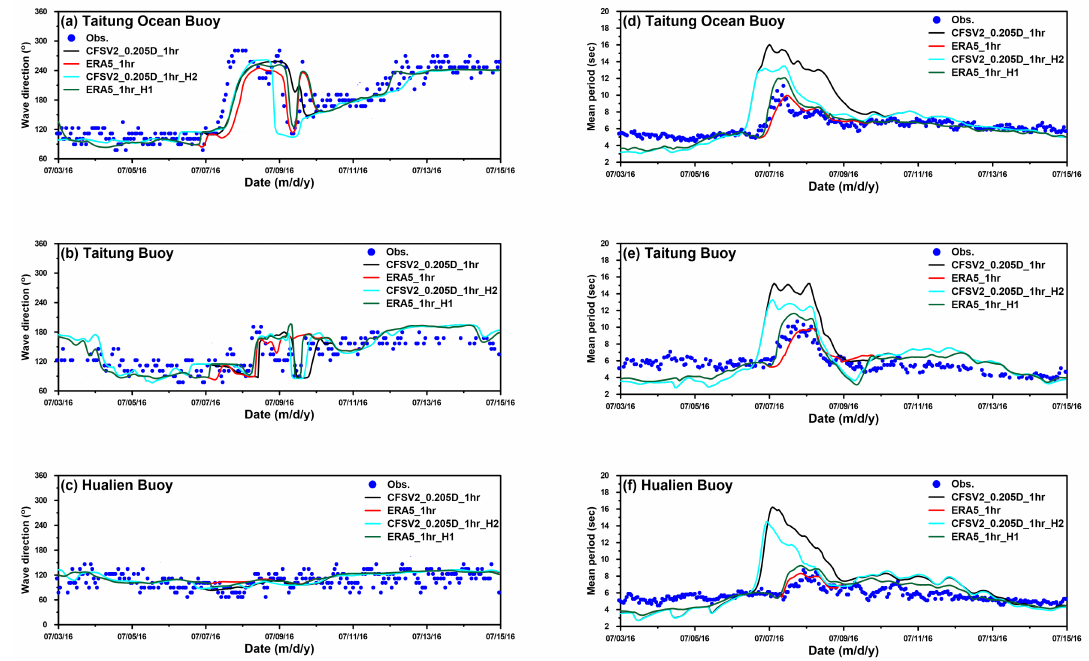
Figure 14. Model-data comparison for the wave direction ( a – c ) and mean wave period ( d – f ) time series at the ( a , d ) Taitung Ocean, ( b , e ) Taitung, and ( c , f ) Hualien buoys employing the winds from CFSV2_0.205D_1hr, ERA5_1hr, CFSV2_0.205D_1hr_H2, and